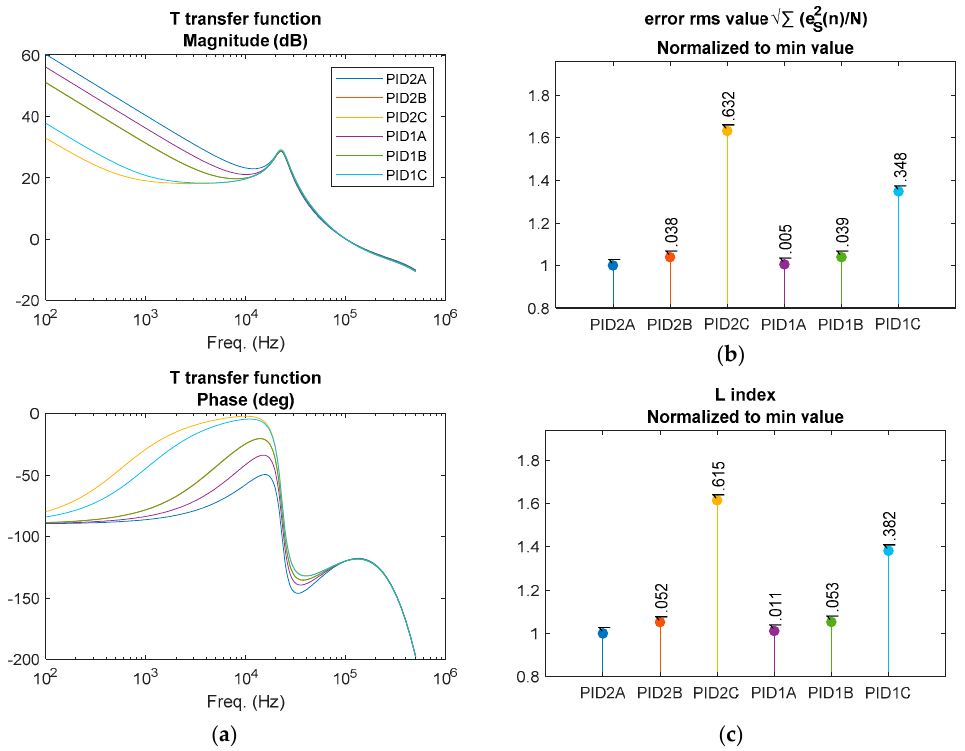
Figure 5. Comparison of solutions with the same ( f c , PM ) pair corresponding to different compensator types and parameters. ( a ) Open-loop transfer function; ( b ) RMS value of the error signal obtained from the simulation; ( c ) L index obtained from the open-loop transfer function.